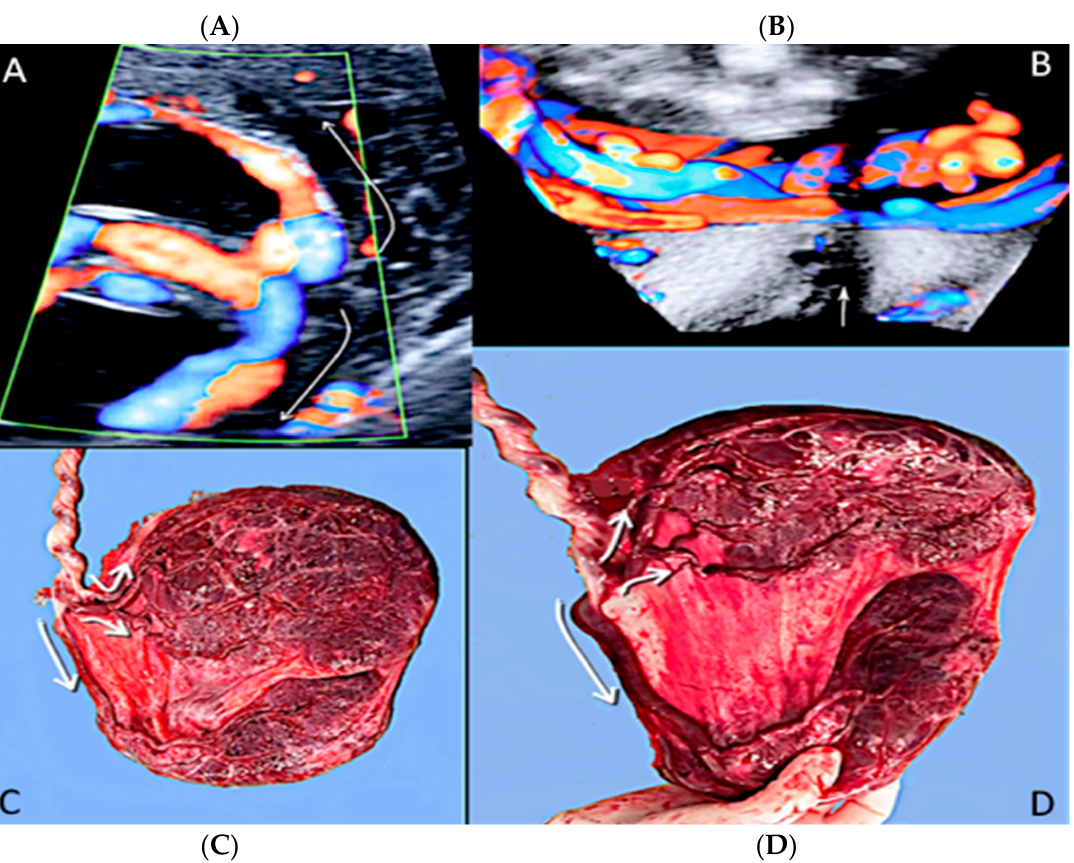
Figure 7. Pregnancy at 21 weeks’ gestation. Succenturiate placenta and placenta praevia Type II. Color Doppler and four-dimensional (4D) STIC with color Doppler. Low-lying placenta and acces- sory lobe are connected by intramembranous blood vessels, with the umbilical cord originating from the main placenta ( A ). Vasa praevia and contemporaneous cord procidentia are highlighted (cervical canal is indicated by a small arrow) ( B ). Pathologic correlation ( C , D ) showed two sepa- rate placental lobes interconnected by membranes, with blood vessels traversing the membranes (indicated by curved arrows).